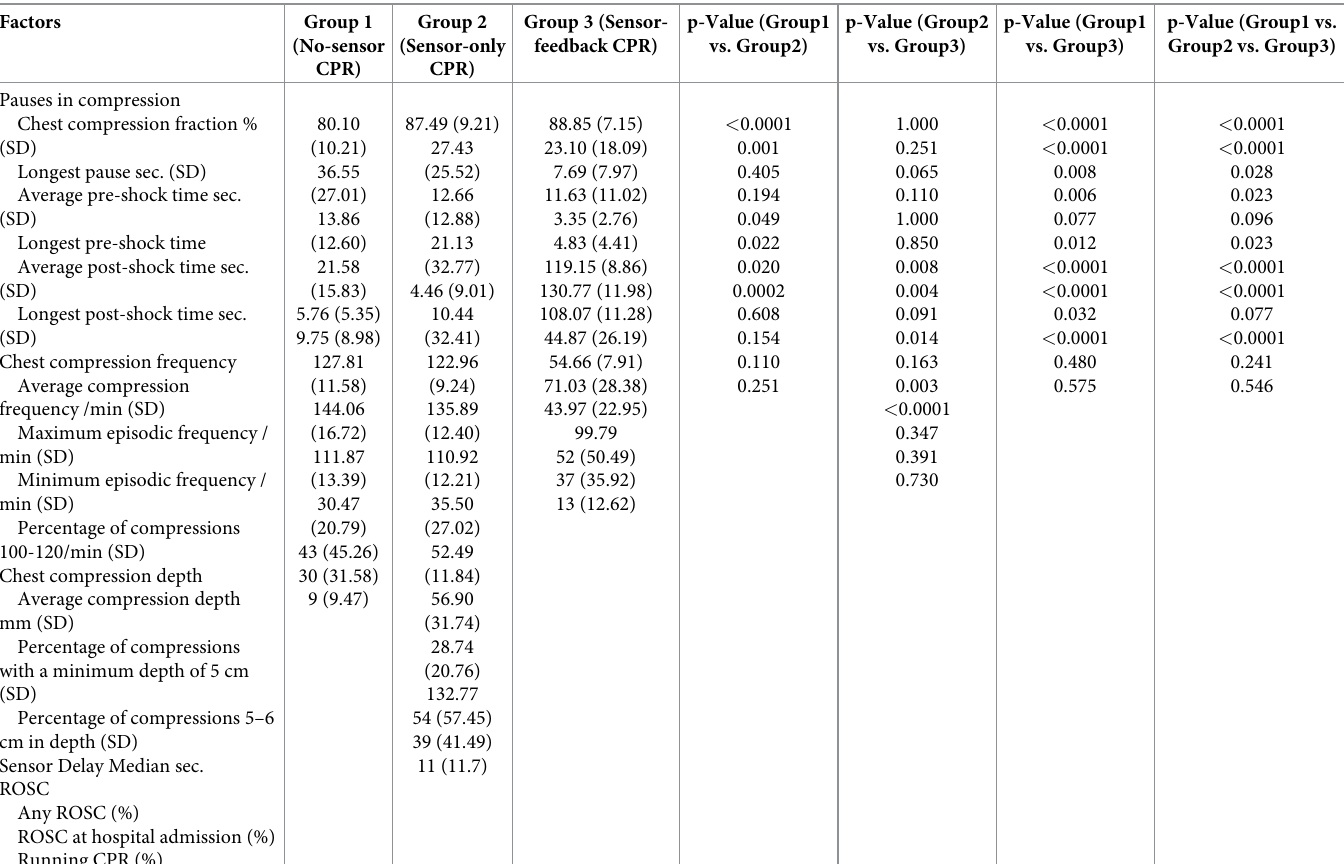
Table 3. Results in comparison of all study groups on compression